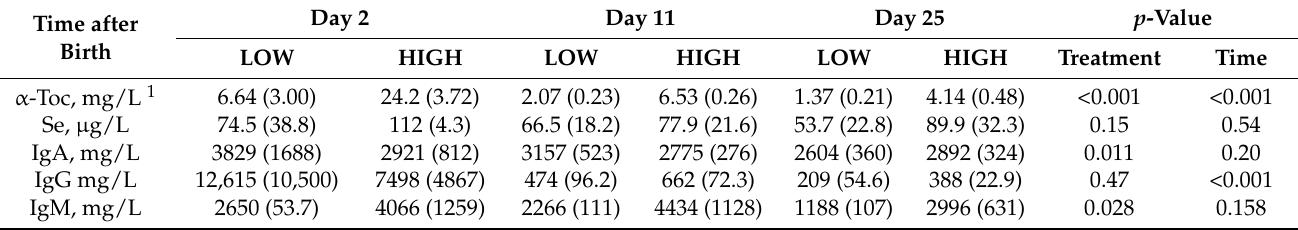
Table 1. Effect of dietary antioxidant level 1 on concentration of vitamin E ( α -Toc.), selenium (Se) and immunoglobulins (Ig) A, G, and M in colostrum (day 2) and milk of sows ( n = 3 sows per treatment. Means and standard error of mean (SEM)). Time after